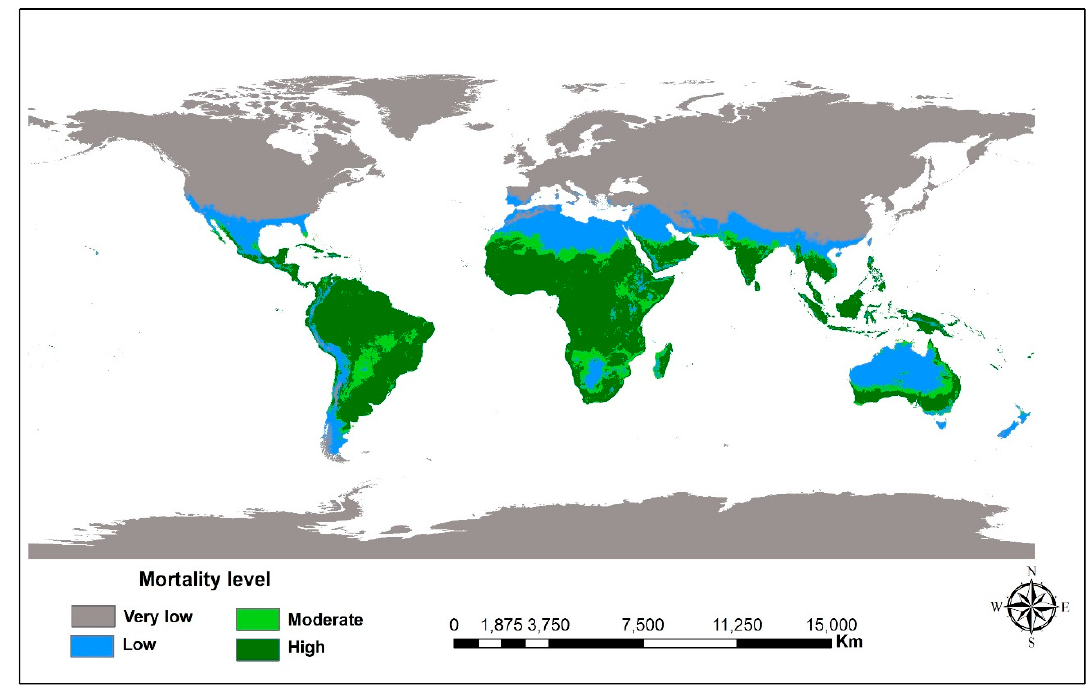
Figure 4. Global map predicting the efficacy of M. anisopliae isolate ICIPE 69 against Z. cucurbitae using the geospatial temperature data layer and the best fitted quadratic model.